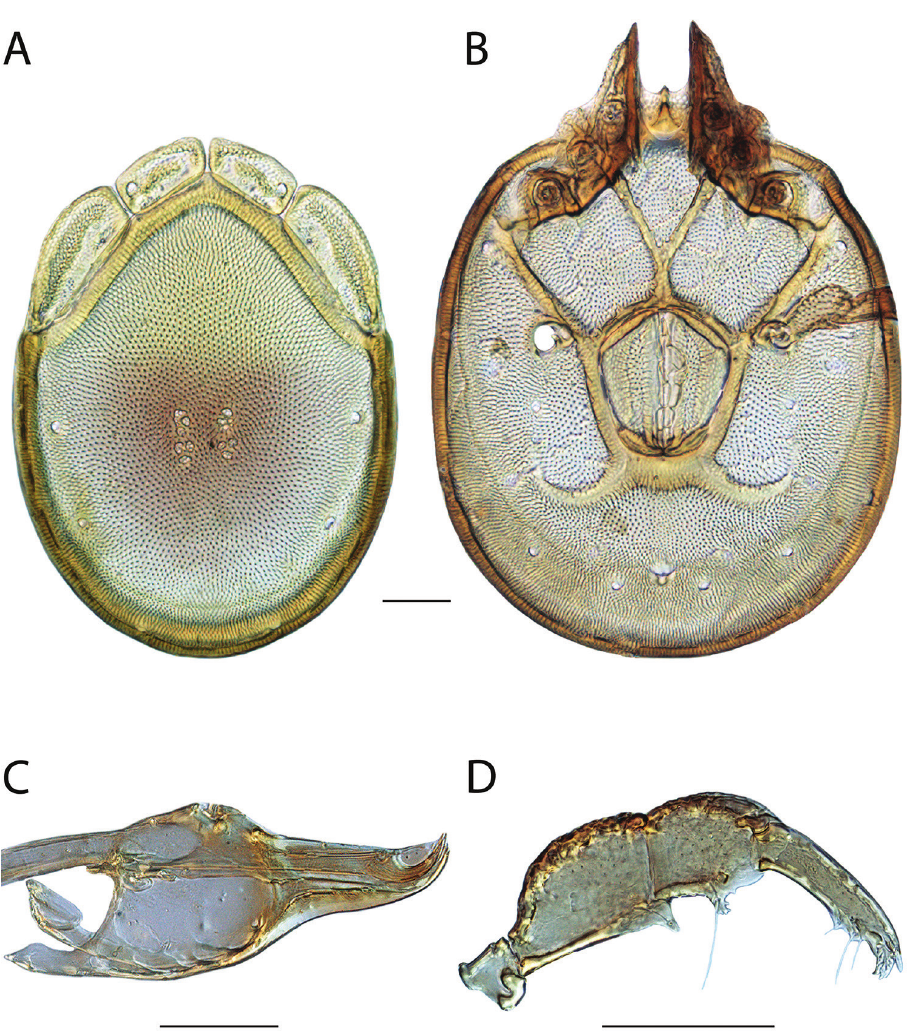
Figure 179. Torrenticola oregonensis sp. n. female: A dorsal plates B venter (legs removed) C subcapitulum D pedipalp (setae not accurately depicted). Scale = 100